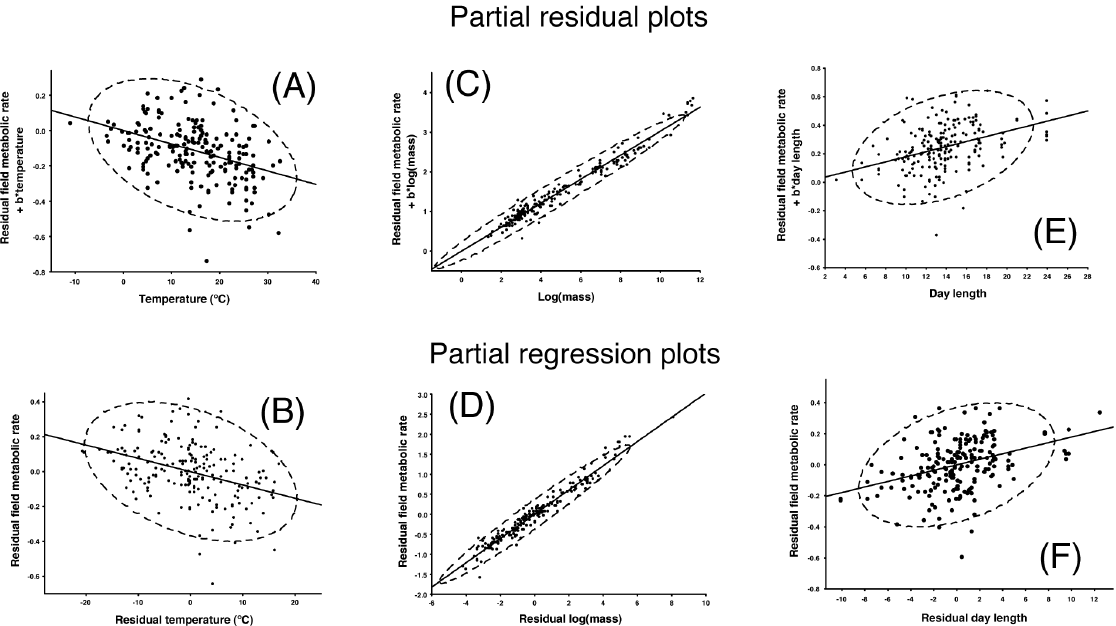
Fig. A1. Partial residual and partial regression plots from data in Fig. 4 of Anderson and Jetz (2005). The Y axis shows the residual field metabolic rate (FMR) for a mixture of birds and mammals. The graphs have been extracted from a GLM model that included: group (birds, mammals) and diet (nectarivores, carnivores, omnivores, herbivores) as categorical variables and two of the other three continuous variables in the graphs (i.e. temperature, log(mass) and/or day length). (A) partial residual plot of FMR vs temperature, (B) partial regression plot of FMR vs temperature, (C) partial residual plot of FMR vs log(mass), (D) partial regression plot of FMR vs log(mass), (E) partial residual plot of FMR vs day length and (F) partial regression plot of FMR vs day length. The study, which was conducted to explore the patterns explaining part of the residual variation in the allometry between body mass and energy expenditure, found that temperature and day length may be responsible for latitudinal variation in FMR. The average correlation among predictor variables was extremely low and non-significant (range 0–0.11), which explains why the difference in scatter around the lines for partial residual and partial regression plots is very similar. To facilitate the visual assessment of the scatter of points around the line, we show the 95% predicting ellipse (dashed line) in all partial